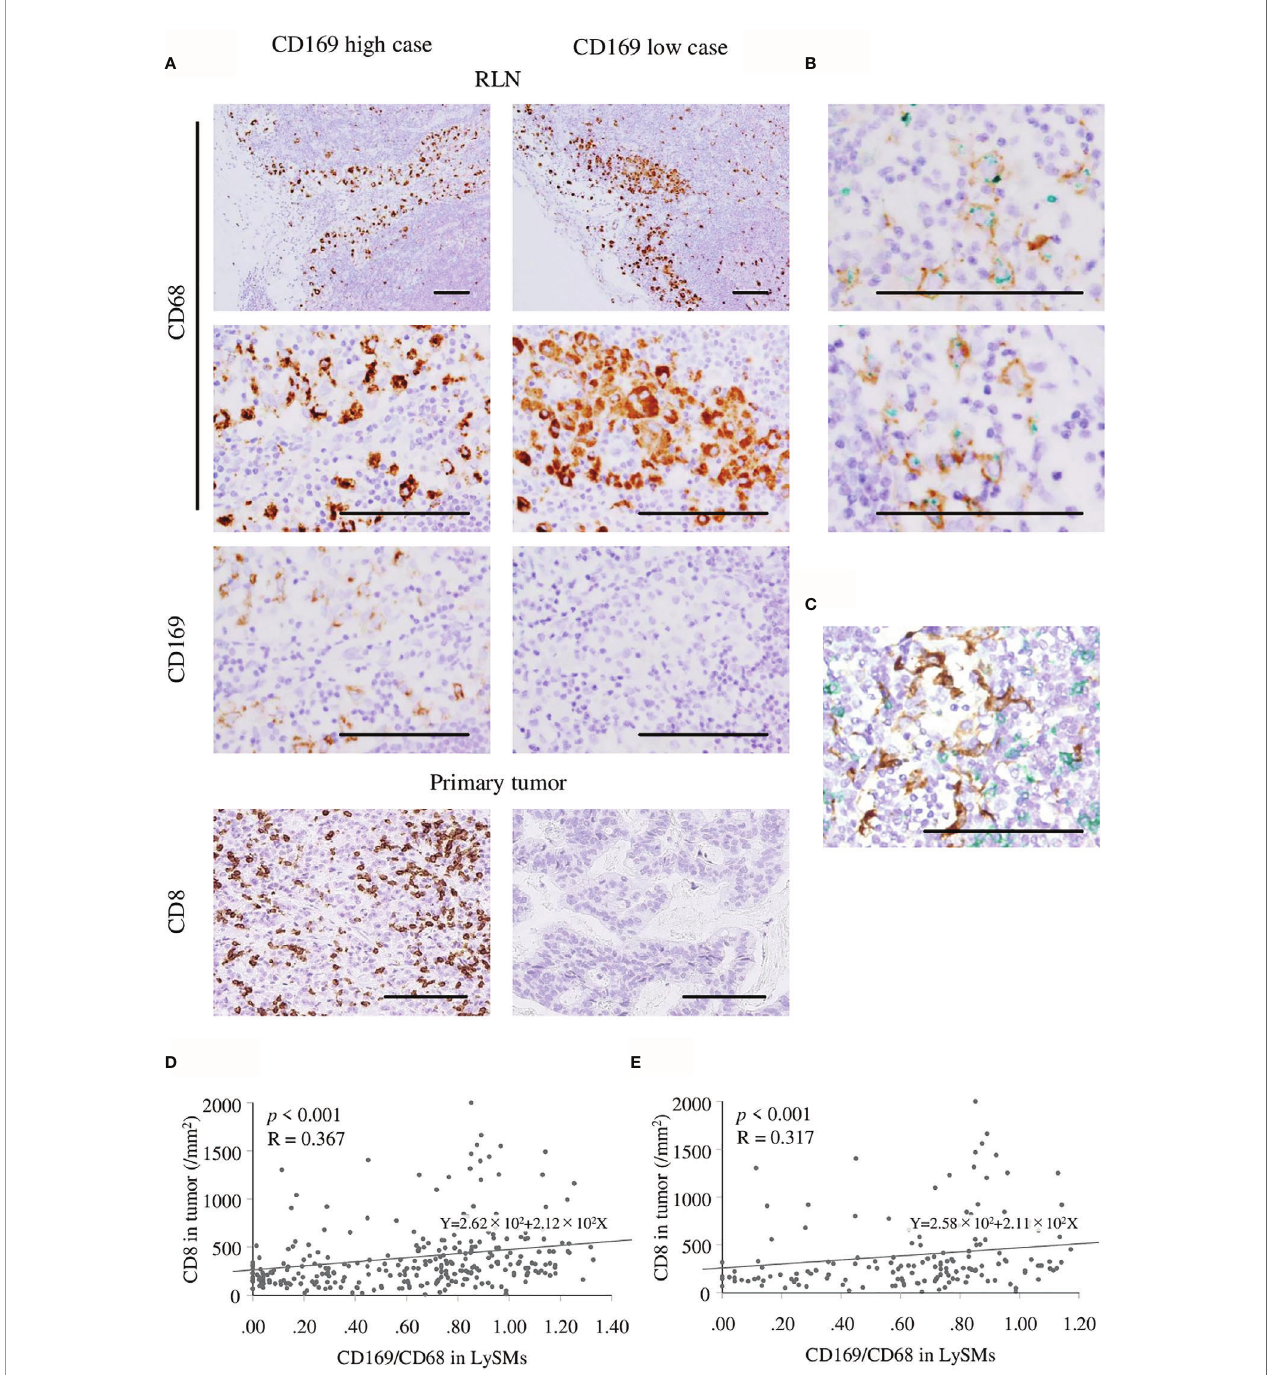
FIGURE 2 | Immunohistochemistry of CD169 + and CD68 + macrophage in regional lymph nodes (RLN), and CD8 + cells in primary tumor. Scale bar = 100 m m. (A) Representative fi gures of immunohistochemistry (IHC) images from CD169 high and low cases are shown. Lymph node sinus macrophages (LySMs) were positive for CD68 in both two patients, although, CD169 expression differed. High in fi ltration of CD8 + T cells in primary tumor tissues was seen in a CD169 high case and low in fi ltration of CD8 + T cells in primary tumor tissues was seen in a CD169 low case. (B) Double IHC of CD68(green) and CD169(brown) showed CD169 was expressed on CD68-positive macrophages. Correlation between the number of CD8 + T cells in primary tumor tissues and CD169/CD68 ratio in LySMs were tested by Spearman ’ s correlation test. (C) Double IHC of CD8(green) and CD169(brown) showed the direct cell-cell interaction between LySM and T cells in sinus area. Scatter plots of total (D) and in advanced (E) gastric cancer cases were shown. RLN, regional lymph